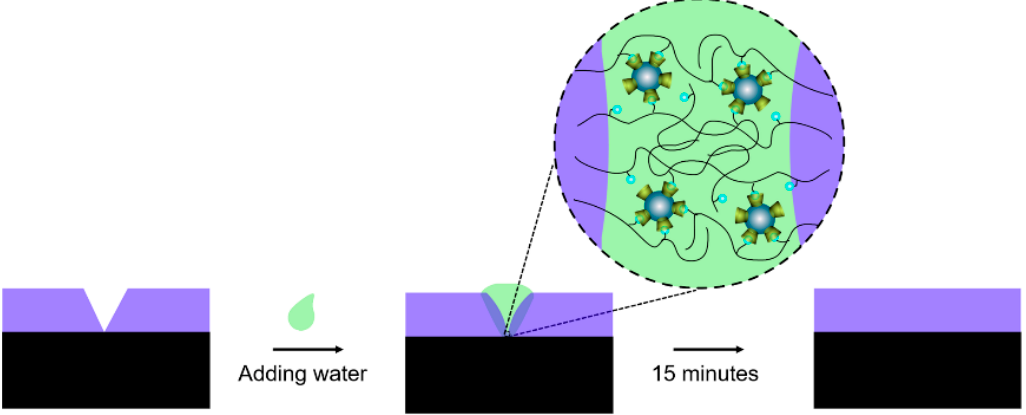
Figure 1. Self-healing mechanism of β -CD-TiO 2 /P(HEMA-co-BA).